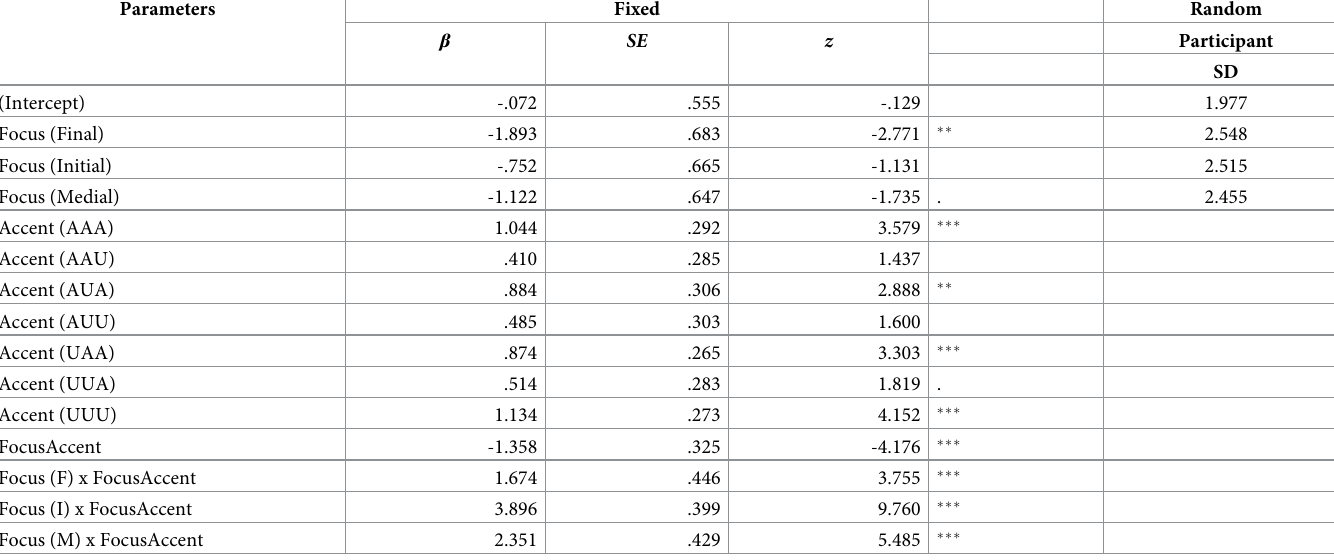
Table 3. Model summary: Correct response ~ Focus + Accent + FocusAccent + Focus × FocusAccent + (Focus | Group:Subject). Pr( > |z|) -values: � < .05, �� < .01, ��� < .001. In the parameters, ‘I’ = Initial focus, ‘M’ = Medial, ‘F’ = Final, ‘N’ = Neutral, ‘A’ = Accented, ‘U’ = Unaccented. Parameters